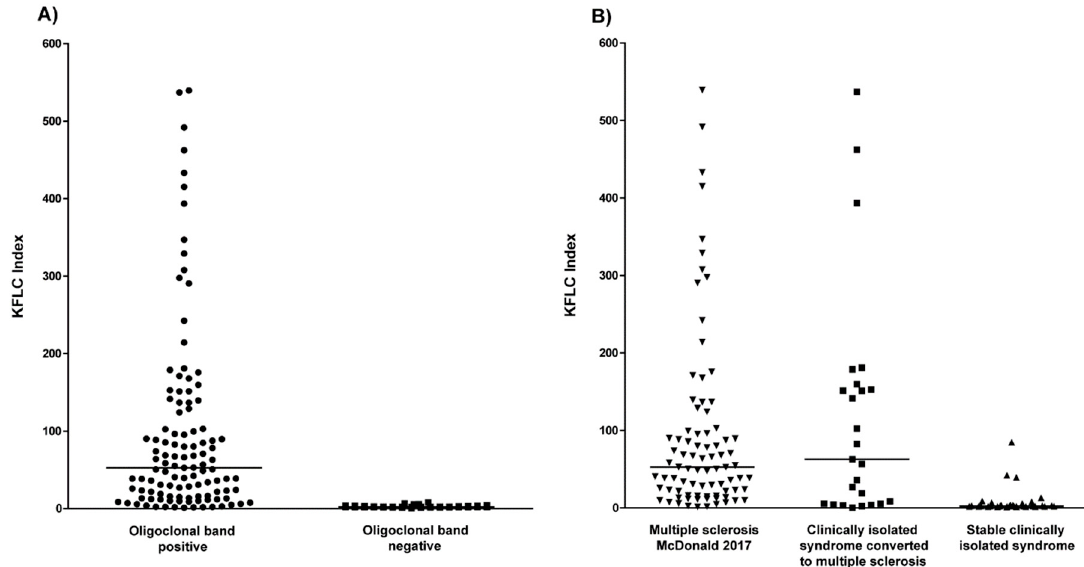
Figure 1. Kappa free light chain (KFLC) index in different cohorts. ( A ) The KFLC index defined as (KFLC in cerebrospinal fluid (CSF)/KFLC in serum) divided by albumin quotient (albumin in CSF/albumin in serum) in all patients with positive (dots) and negative oligoclonal bands (squares). ( B ) The KFLC index in patients diagnosed with multiple sclerosis according to the McDonald criteria of 2017 (down arrowhead), clinically isolated syndrome who converted to multiple sclerosis during follow-up (squares), and stable clinically isolated syndrome (up arrowhead).